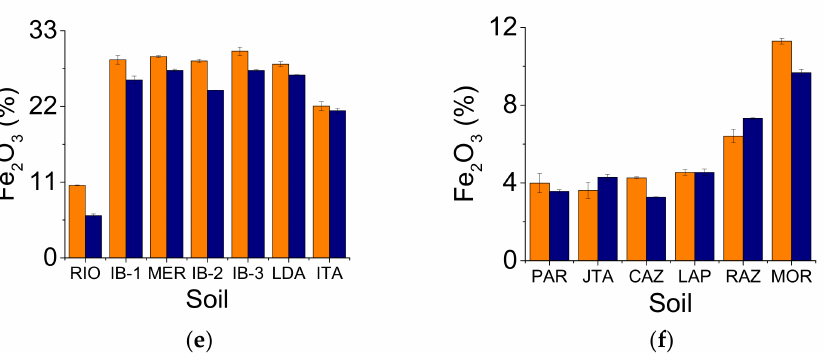
Figure 1. ( a , c , e ) Major soil oxide contents (Al 2 O 3 , SiO 2 , Fe 2 O 3 ) for the different aggregate sizes (2–1 mm and <45 µ m) for the clayey soils. ( b , d , f ) Major soil oxide contents for the different aggregate sizes for the loamy/sandy soils. Vertical bars represent the standard deviation (n =